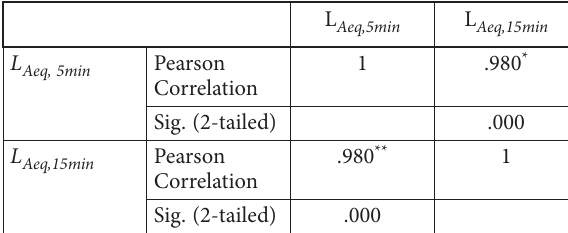
Figure 4. Placement of video recording camera on a pedestrian bridge